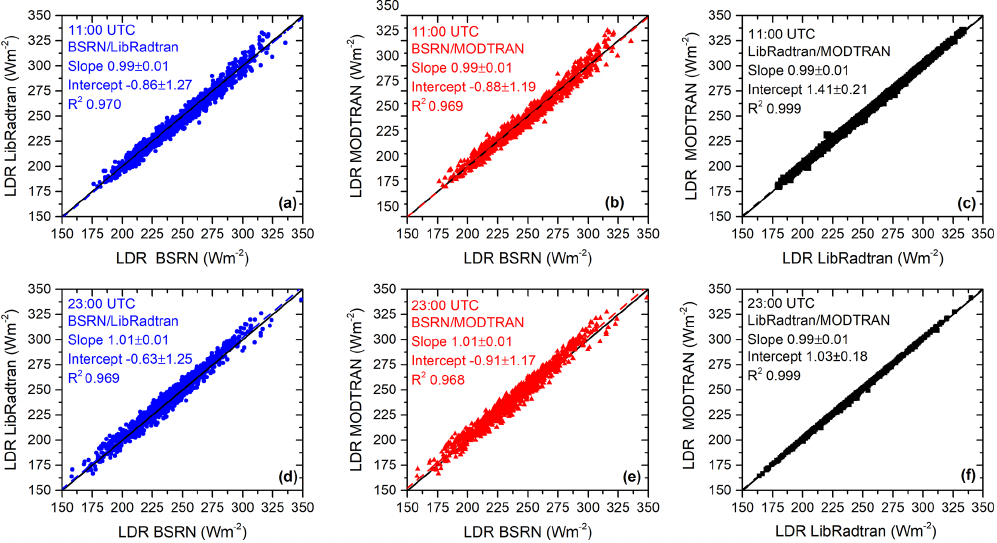
Figure 3. Scatter plot of the LDR (Wm − 2 ) simulations with libRadtran (blue) vs. BSRN LDR (Wm − 2 ) at cloud-free (a) daytime and (d) night-time. Scatter plot of the MODTRAN LDR (Wm − 2 ; red) vs. BSRN LDR (Wm − 2 ) at (b) daytime and (e) night-time, and scatter plot of the MODTRAN LDR (Wm − 2 ; black) vs. libRadtran LDR (Wm − 2 ) at (c) daytime and (f) night-time. The black solid lines show x = y . The dashed lines represent the least-square fits and the fitting parameters are shown in the legend.